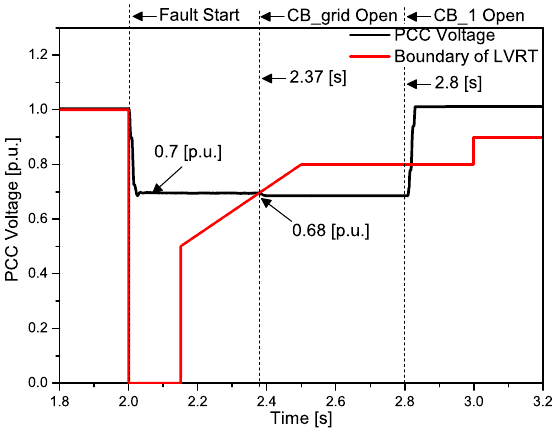
Figure 8. Point of common coupling (PCC) voltage without an SFCL.